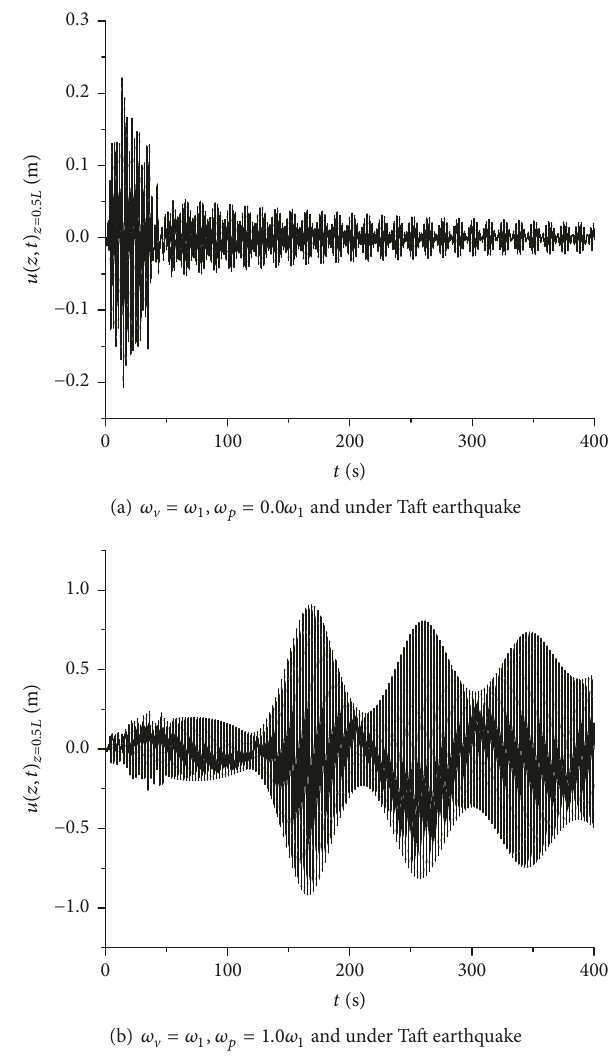
Figure 10: The effect of earthquake on the dynamic response of the